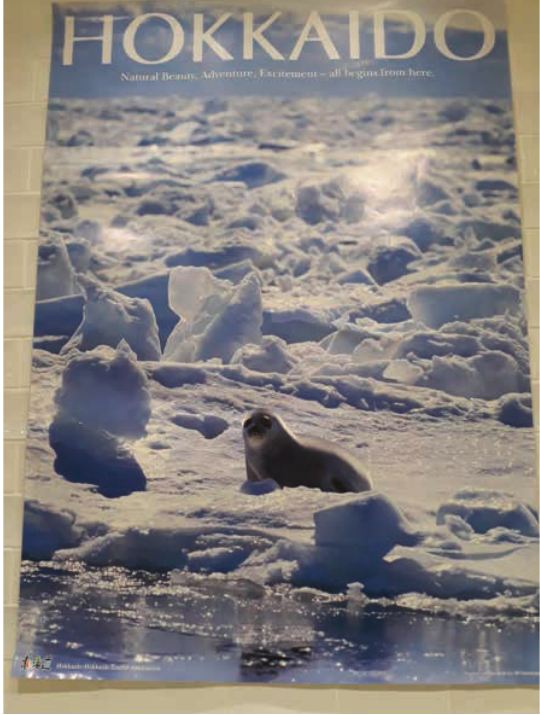
Figure 5: Hokkaido Winter scene- Hokkaido Tourism, “Natural Beauty. Adventure. Excitement—all begins from